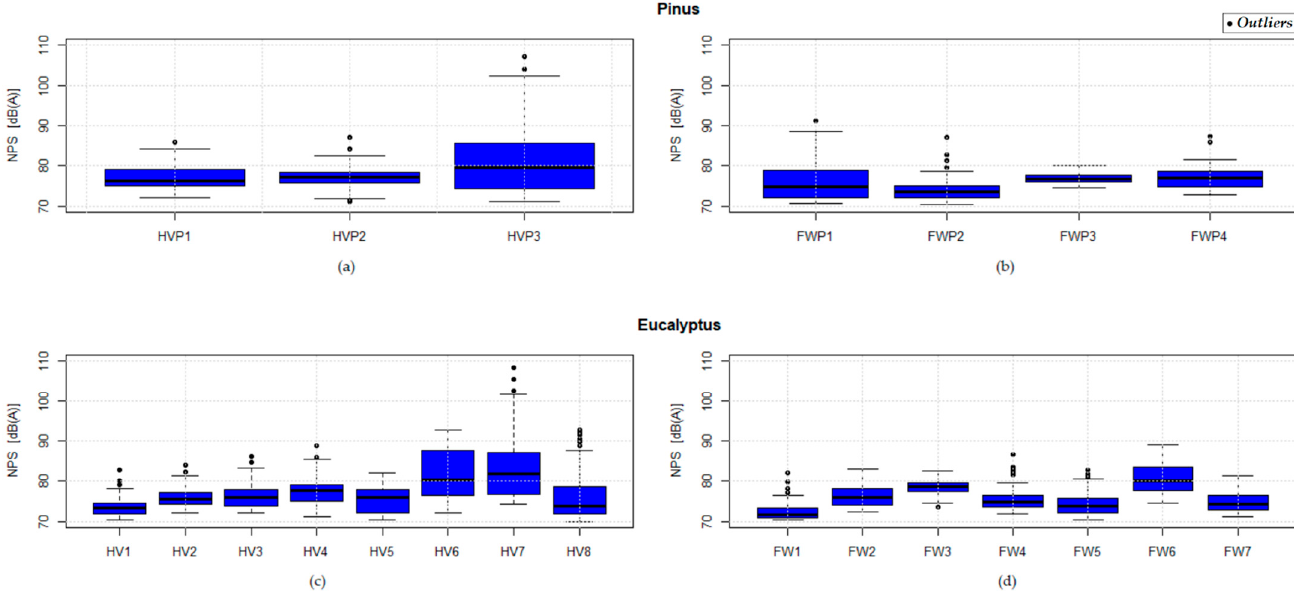
Figure 1. Comparative analysis of the elements of each homogeneous group. ( a ) GH1, ( b ) GH2, ( c ) GH3 and ( d ) GH4.